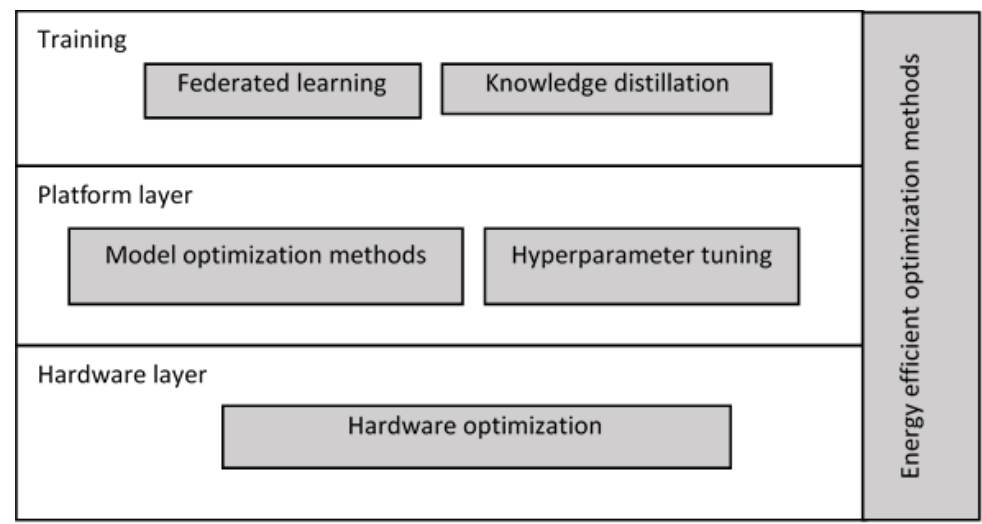
Figure 4. Categories of optimization methods are placed against the inherent technology stack of an AI application.